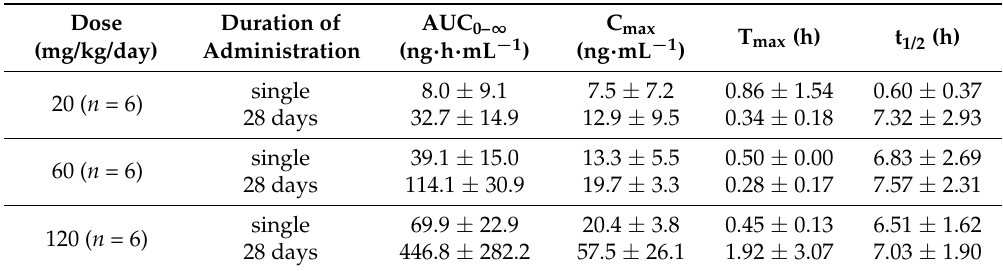
Table 9. Mean ( ± SD) toxicokinetic parameters of HZ1006 after oral administration in doses of 20, 60, and 120 mg/kg/day to SD